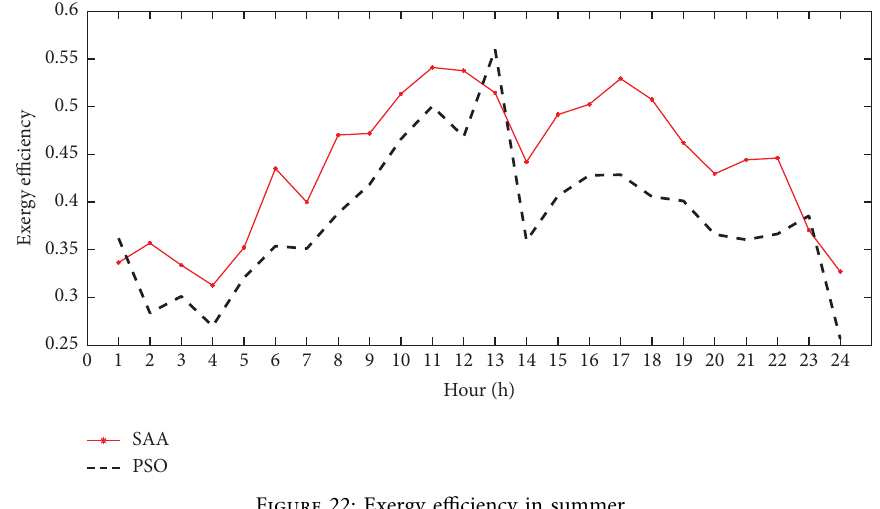
Figure 22: Exergy efciency in summer.